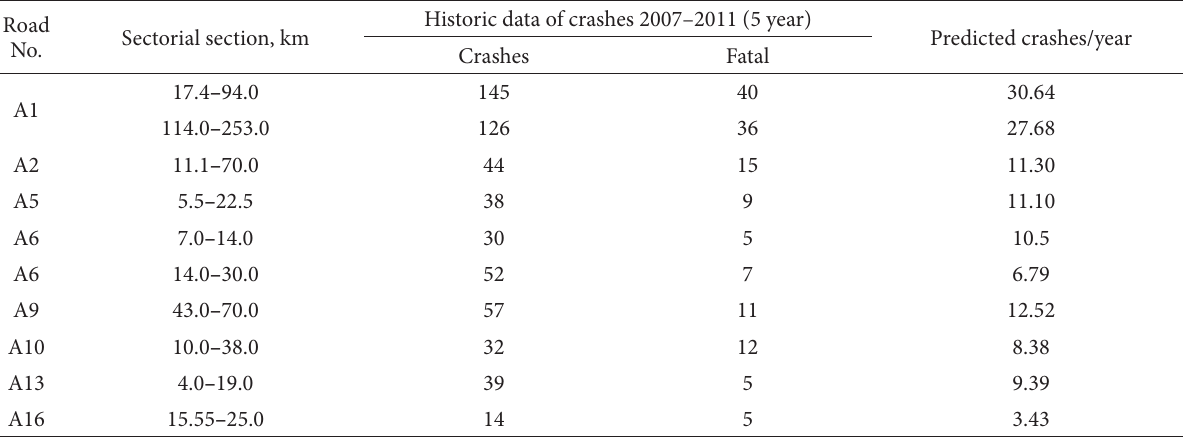
Table 3. Data of road crashes on road sections selected for the installation of a sectorial speed enforcement system Road No.